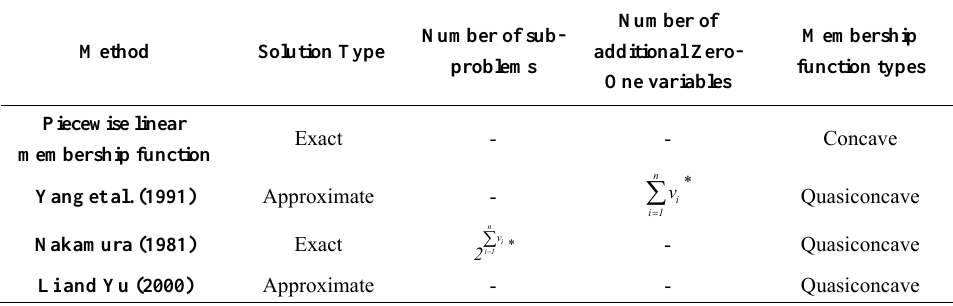
Table 10. Comparative analysis on different approaches of solving FMOLP